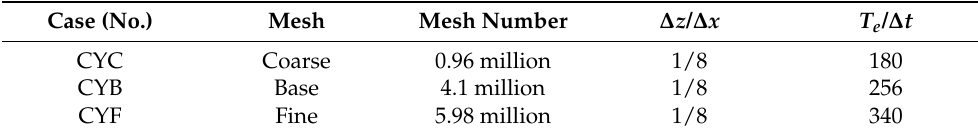
Table 5. Test Cases of